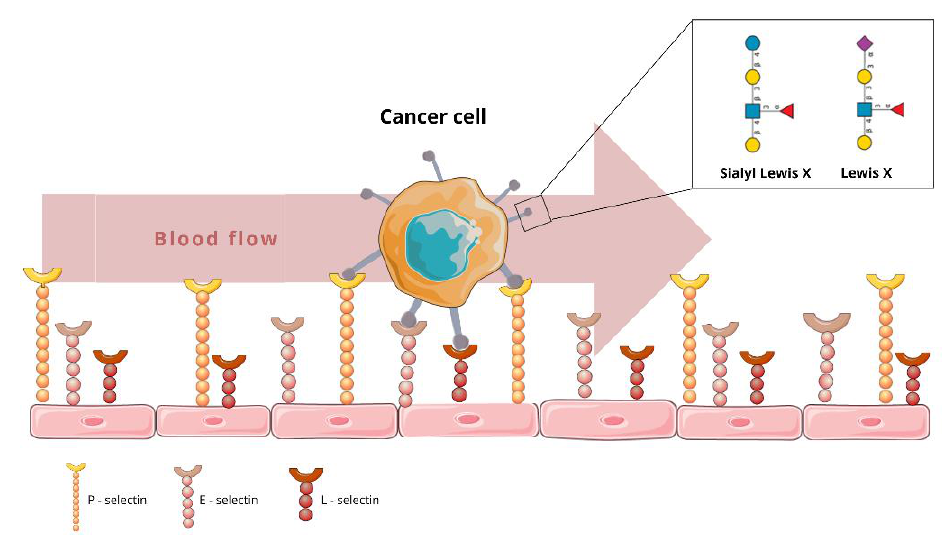
Figure 2. Cancer cell adhesion to endothelial cells by the Lewis X antigen interacting with E-, L- and P-selectins. The figure presents the first step in the transendothelial migration of cancer cells.